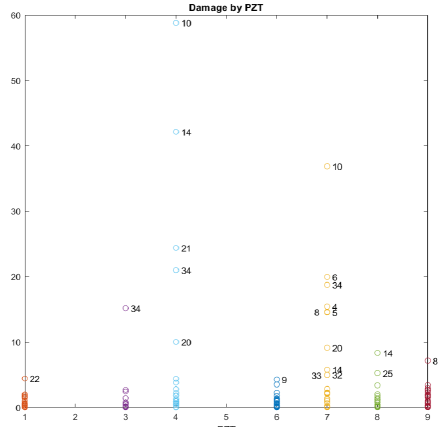
Figure 10. Damage index using the original state of the beam as the baseline.